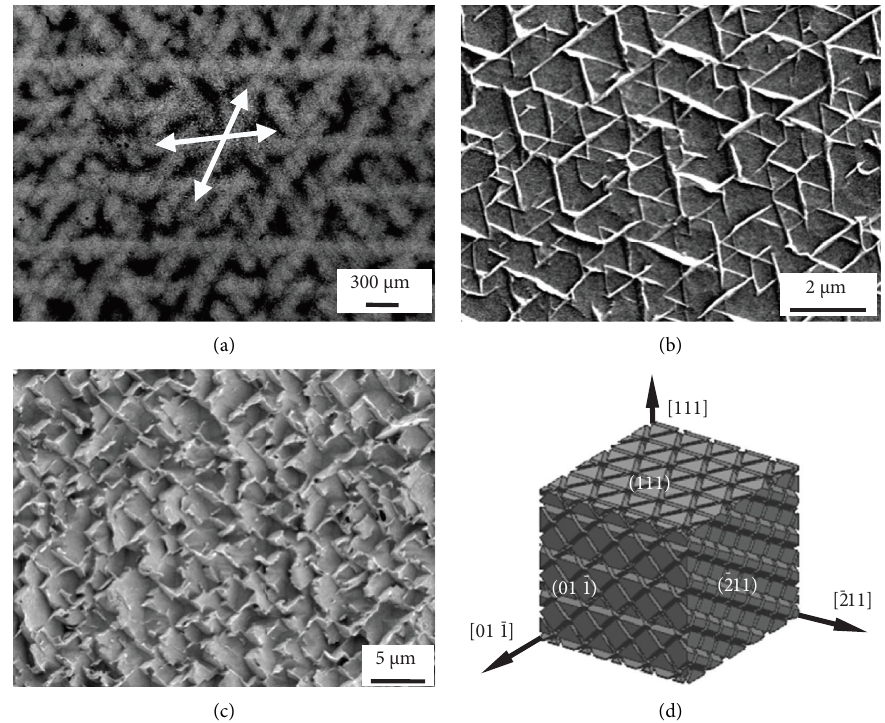
Figure 1: Dendritic morphology and microstructure of the c ′ phase: (a) dendritic morphology of the (111) plane, (b) c ′ phase morphology of the (111) plane, (c) c ′ phase morphology of the (01 ‾ 1) plane, and (d) stacking diagram of the c ′ phase with the [111] orientation.